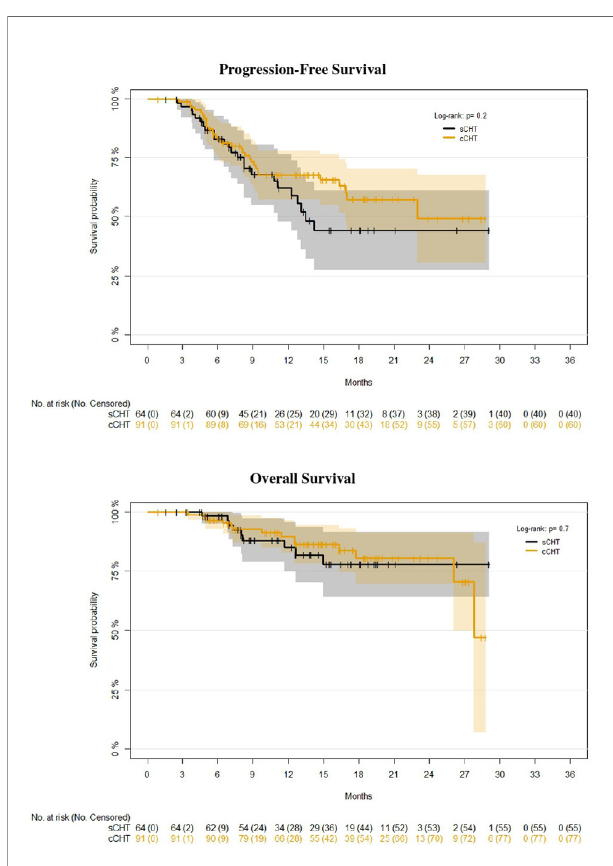
FIGURE 2 | Kaplan – Meier survival estimates (progression-free and overall survival) of concurrent (n = 91) vs. sequential (n = 64) chemoradiotherapy (cCRT vs.